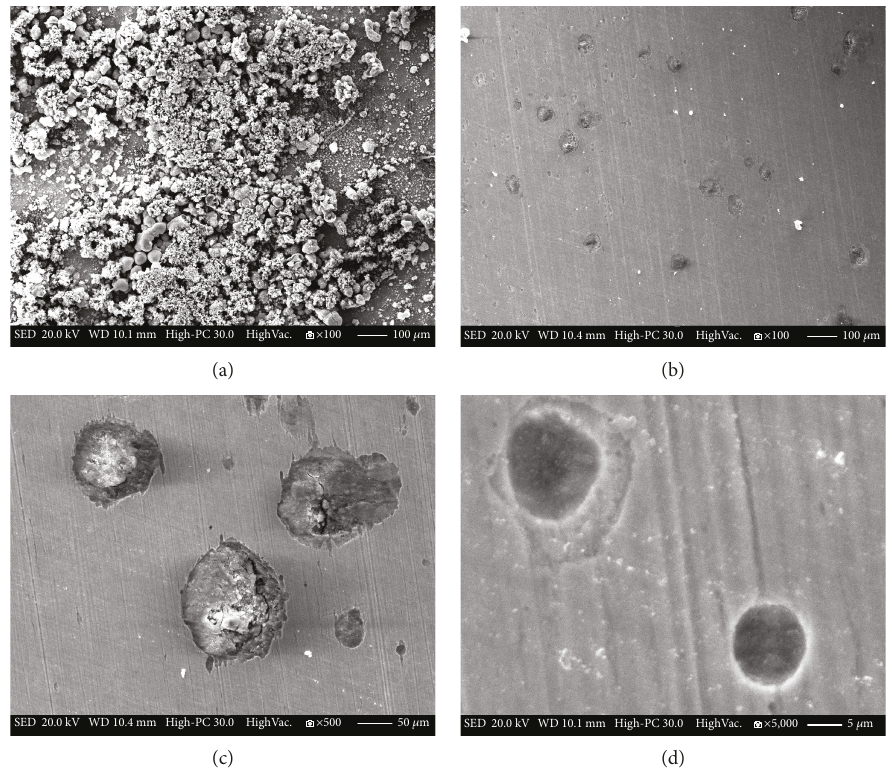
Figure 16: Morphological aspects of carbon steel after 24 hours of immersion in a 3.5% NaCl solution at room